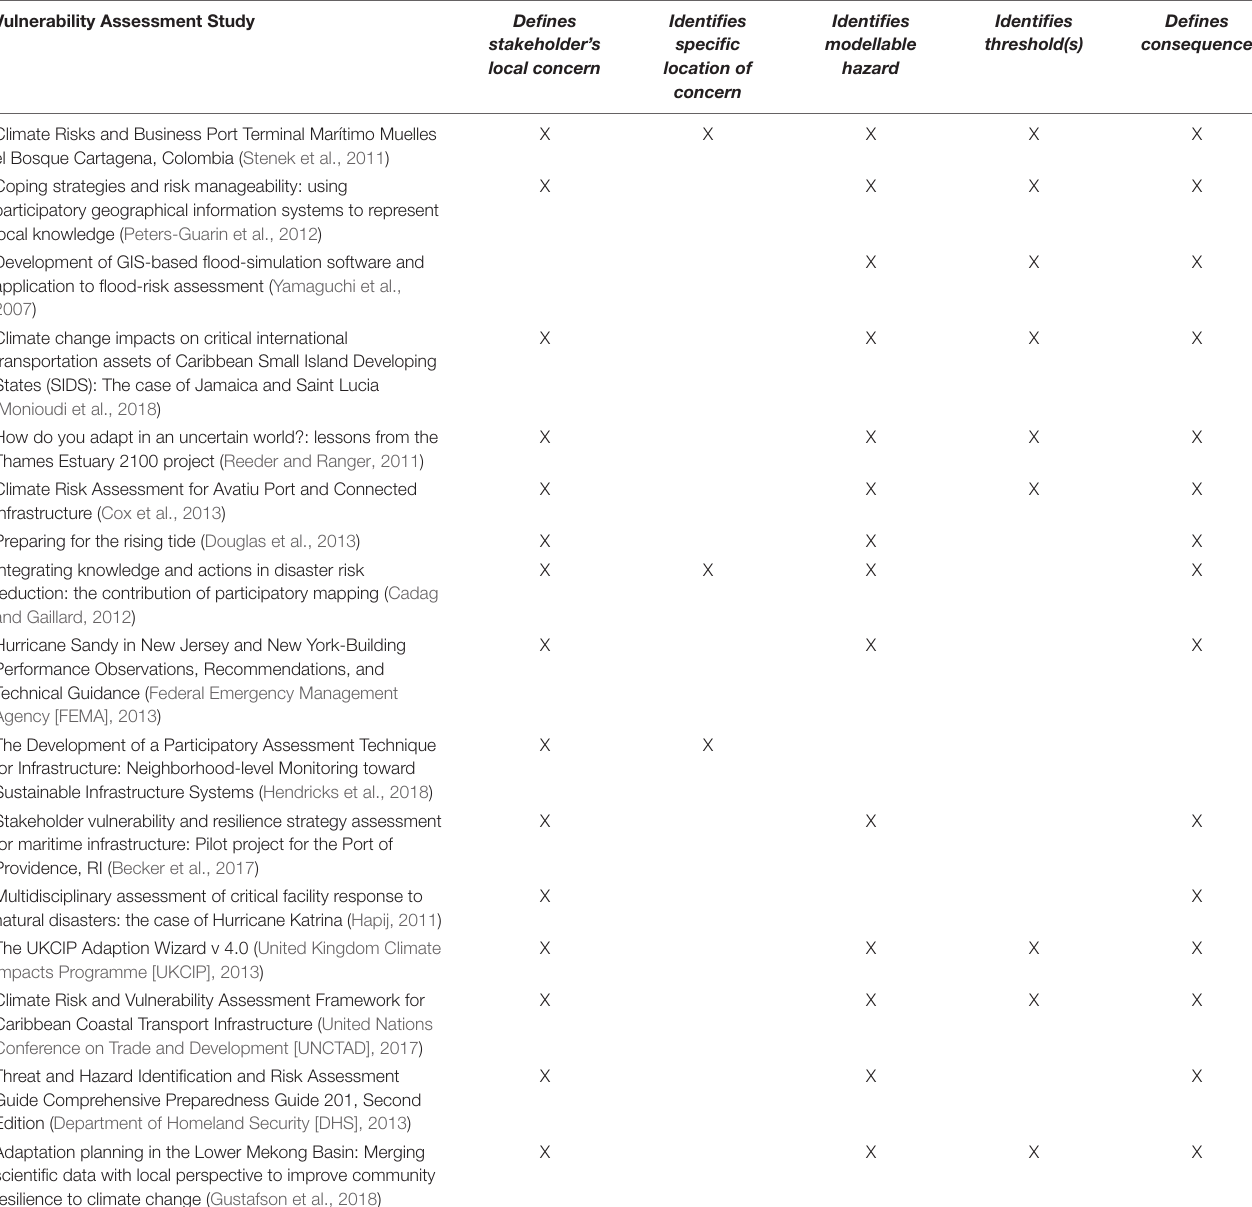
TABLE 1 | Methodologies reviewed for “consequence thresholds”